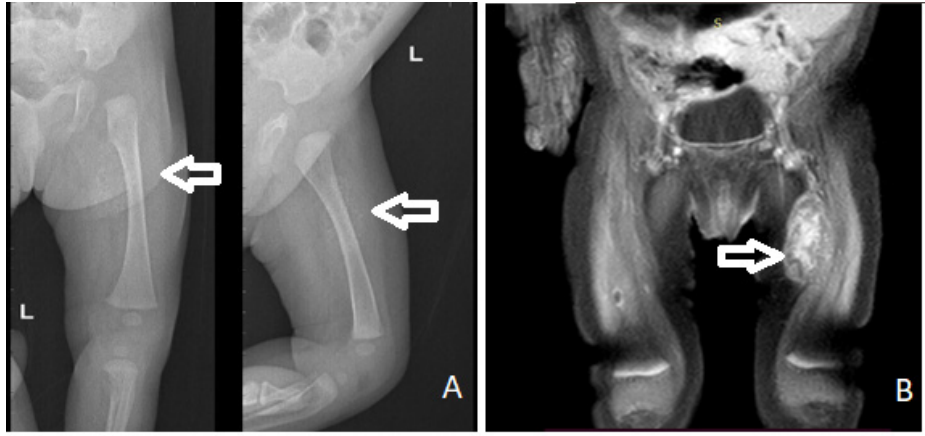
Figure 2. X-ray ( A ) and MRI ( B ) showing a mass on the antero-intern part of the left thigh (arrow). Magnetic resonance imaging (MRI) showed a mass of 19,33/15,19/34 mm, with a nonspecific vascular involvement (Figure 2B). In T1-weighted images, the MRI appearance consisted of a low signal. In T2-weighted fat-saturated images, a high signal intensity of the lesion was shown with nonhomogeneous contrast setting after intravascular contrast was administered, but with late homogenization, located on the antero-internal part of the left thigh with an important mass effect on the left vastus intermedius muscle. The lesion was considered to be probably a schwanoma of the left saphenous nerve.